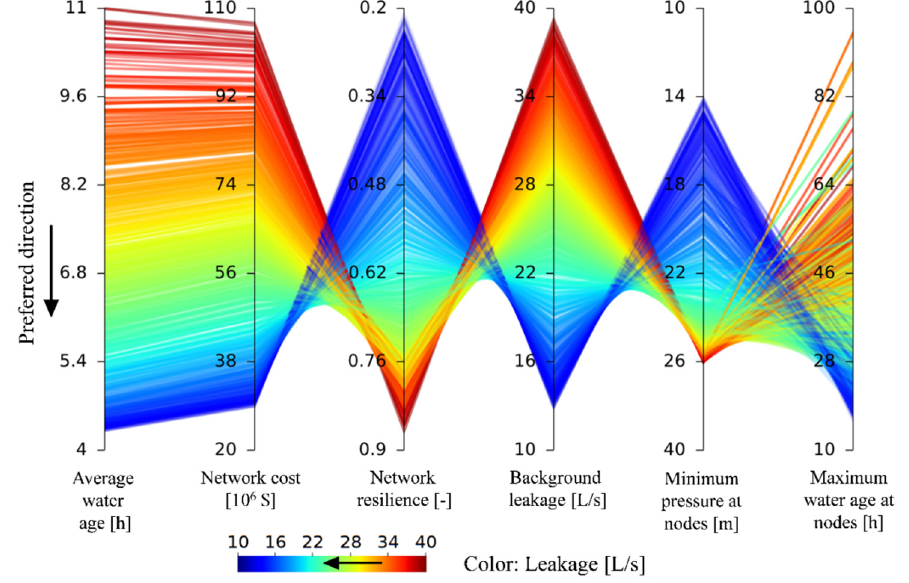
Figure 3. Parallel line plot for the Pareto approximate set (each colored polyline with vertices on the parallel axes represents the objective vector for a single solution, with the arrow pointing in the direction of preference).